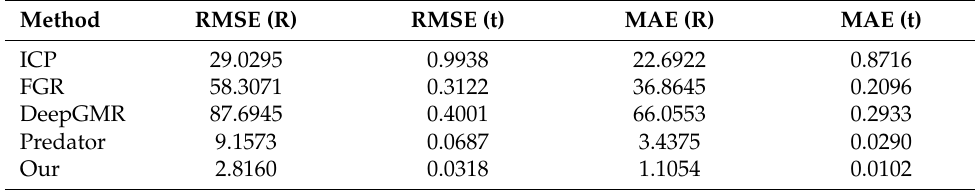
Figure 3. Qualitative results of partial-to-partial point clouds. Table 2. The results of partial-to-partial point clouds.